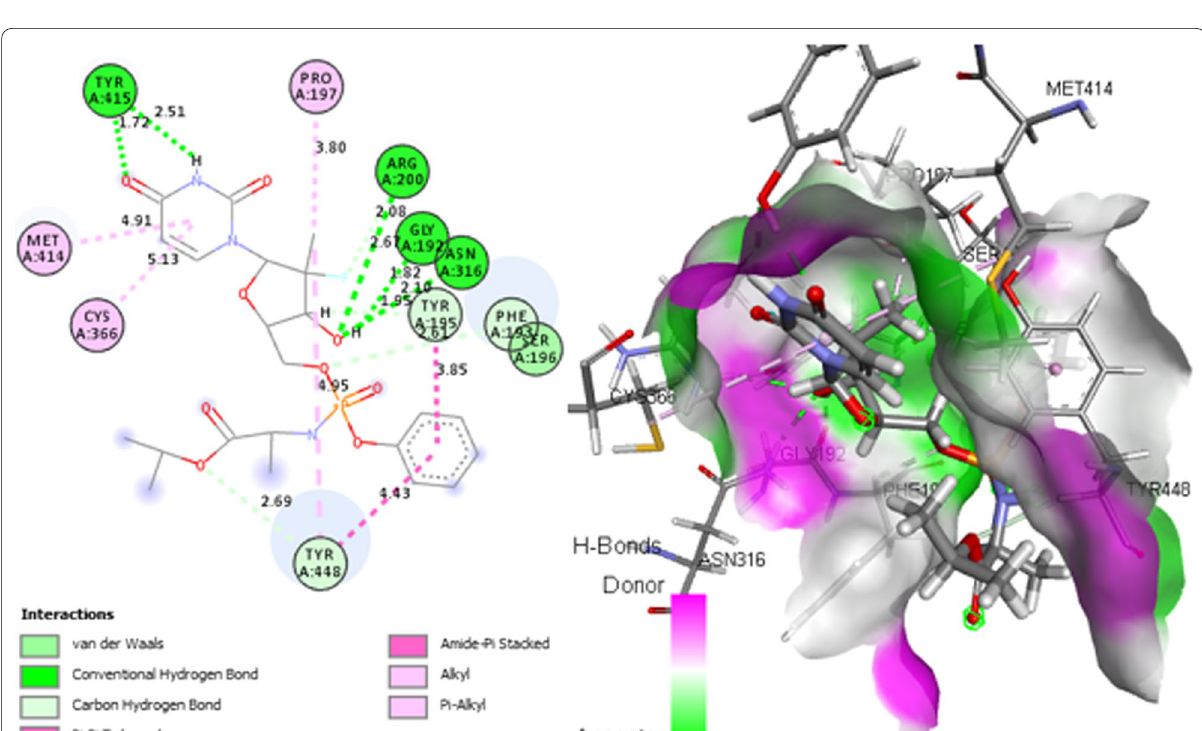
Fig. 5 2D and 3D view of the binding modes of reference molecule (Sofosbuvir) with HCV NS5B